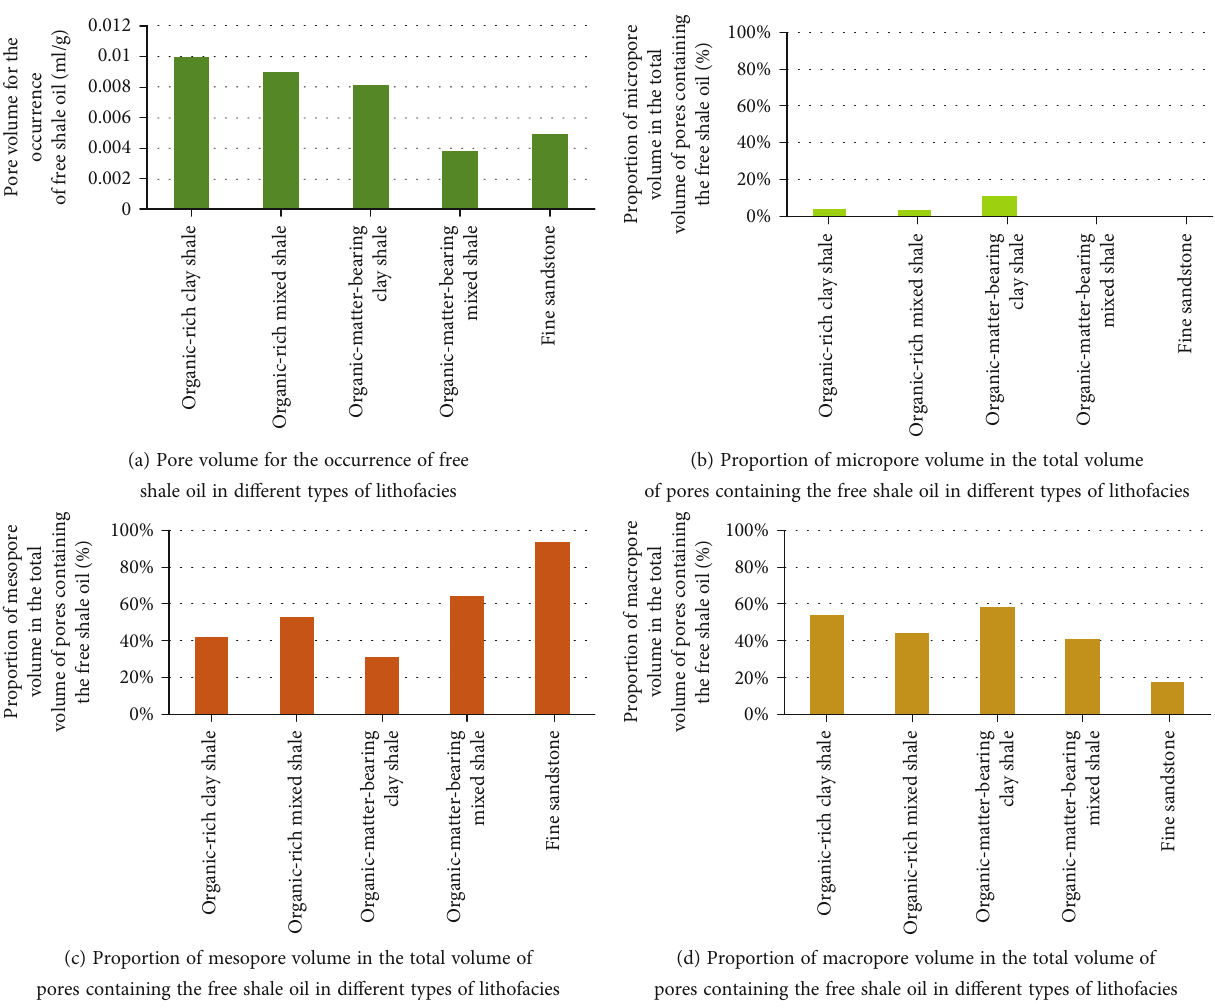
Figure 6: Pore volume characteristics for the occurrence of free shale oil in di ff erent types of lithofacies in TY1